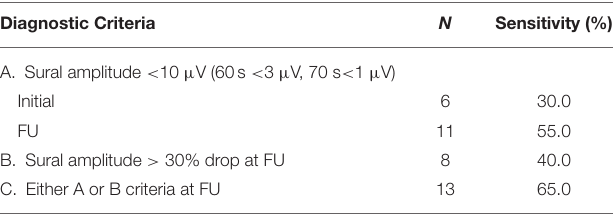
TABLE 2 | Change of NCS Sensitivity for CIPN diagnosis according to sural amplitude difference ( N = 20). Diagnostic